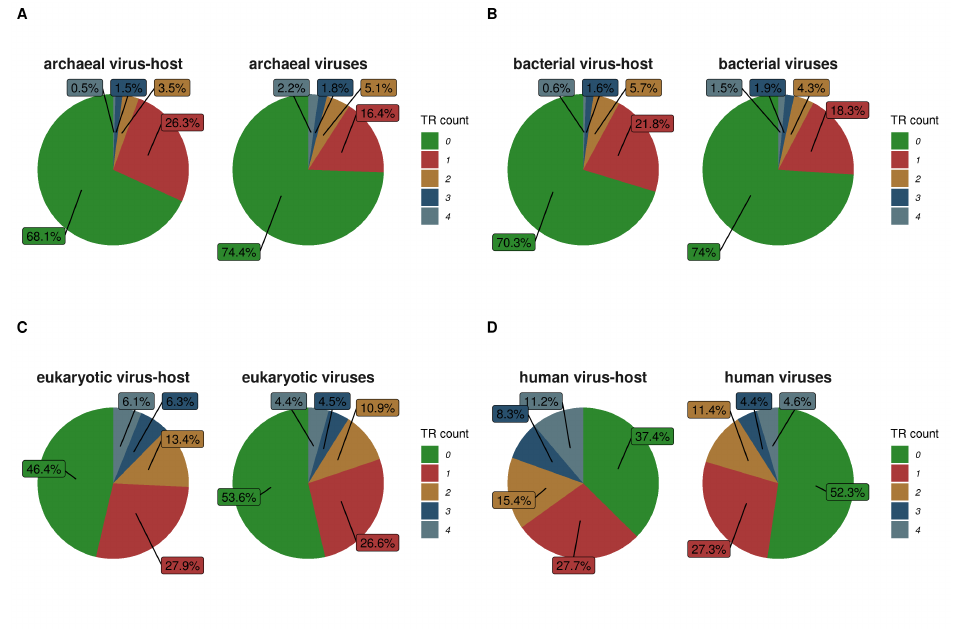
Figure 7. The ratio of the amount of TR per protein is shown as the number of TRs per protein divided by the total amount of proteins per group. Plots ( A – D ) are respectively for archaeal, bacterial, eukaryotic and human virus proteins in comparison to their associated